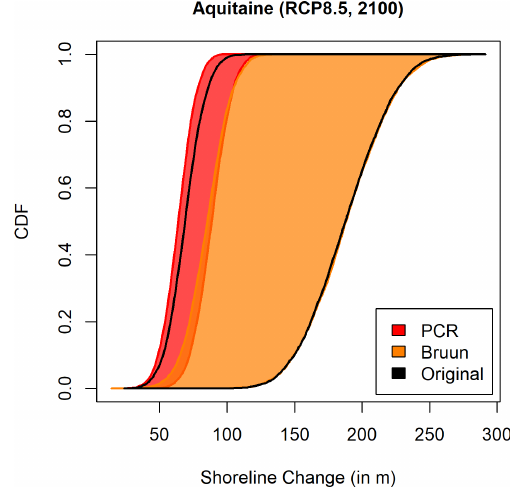
Figure 8. Projected shoreline change p box in 2100 for site 1 un- der the RCP8.5 scenario. The reference model is displayed with the black envelop, and the modified models following the PCR model emulation and Bruun rule, are displayed in red and orange, respec-